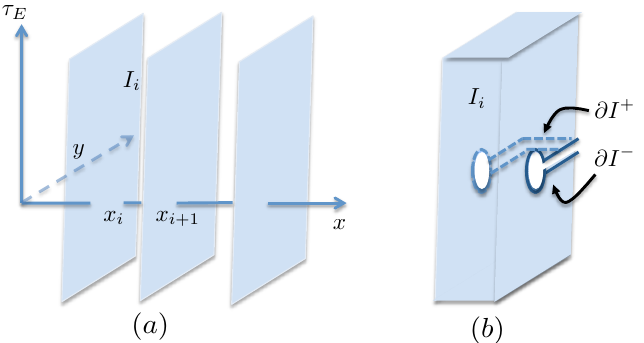
Figure 2 . (a) Partitioning the Euclidean path-integral into slabs in the x directions (b) The path- integral over each slab has (cid:12)ve boundaries. Two boundaries at x i and x i +1 , two at @I + and @I (cid:0) where the state lives, and one in(cid:12)nitesimal cylinder cut around the origin at y = (cid:28) E = 0. Here, (cid:26) ( (cid:30) ; (cid:30) ) is an operator (transfer matrix) that acts only on the subsystem A i i i +1